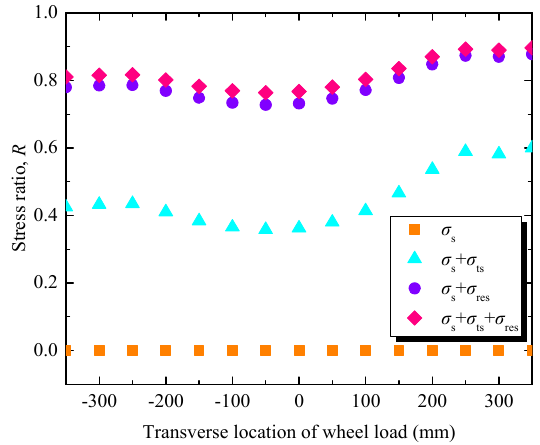
Figure 20. Stress ratio corresponding to different transverse loading positions